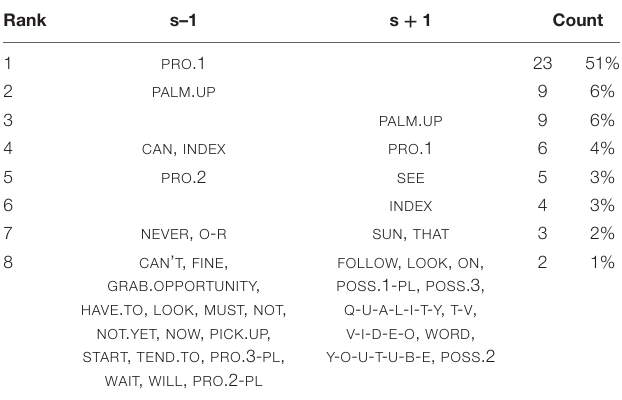
Figure 7 exhibits an utterance with two tokens of LOOK .1/“vision,” both clearly modified for first-person object arguments. The whole utterance co-occurs with CA, and the string of LOOK .1 AT PRO .1 is attested to have two tokens in the